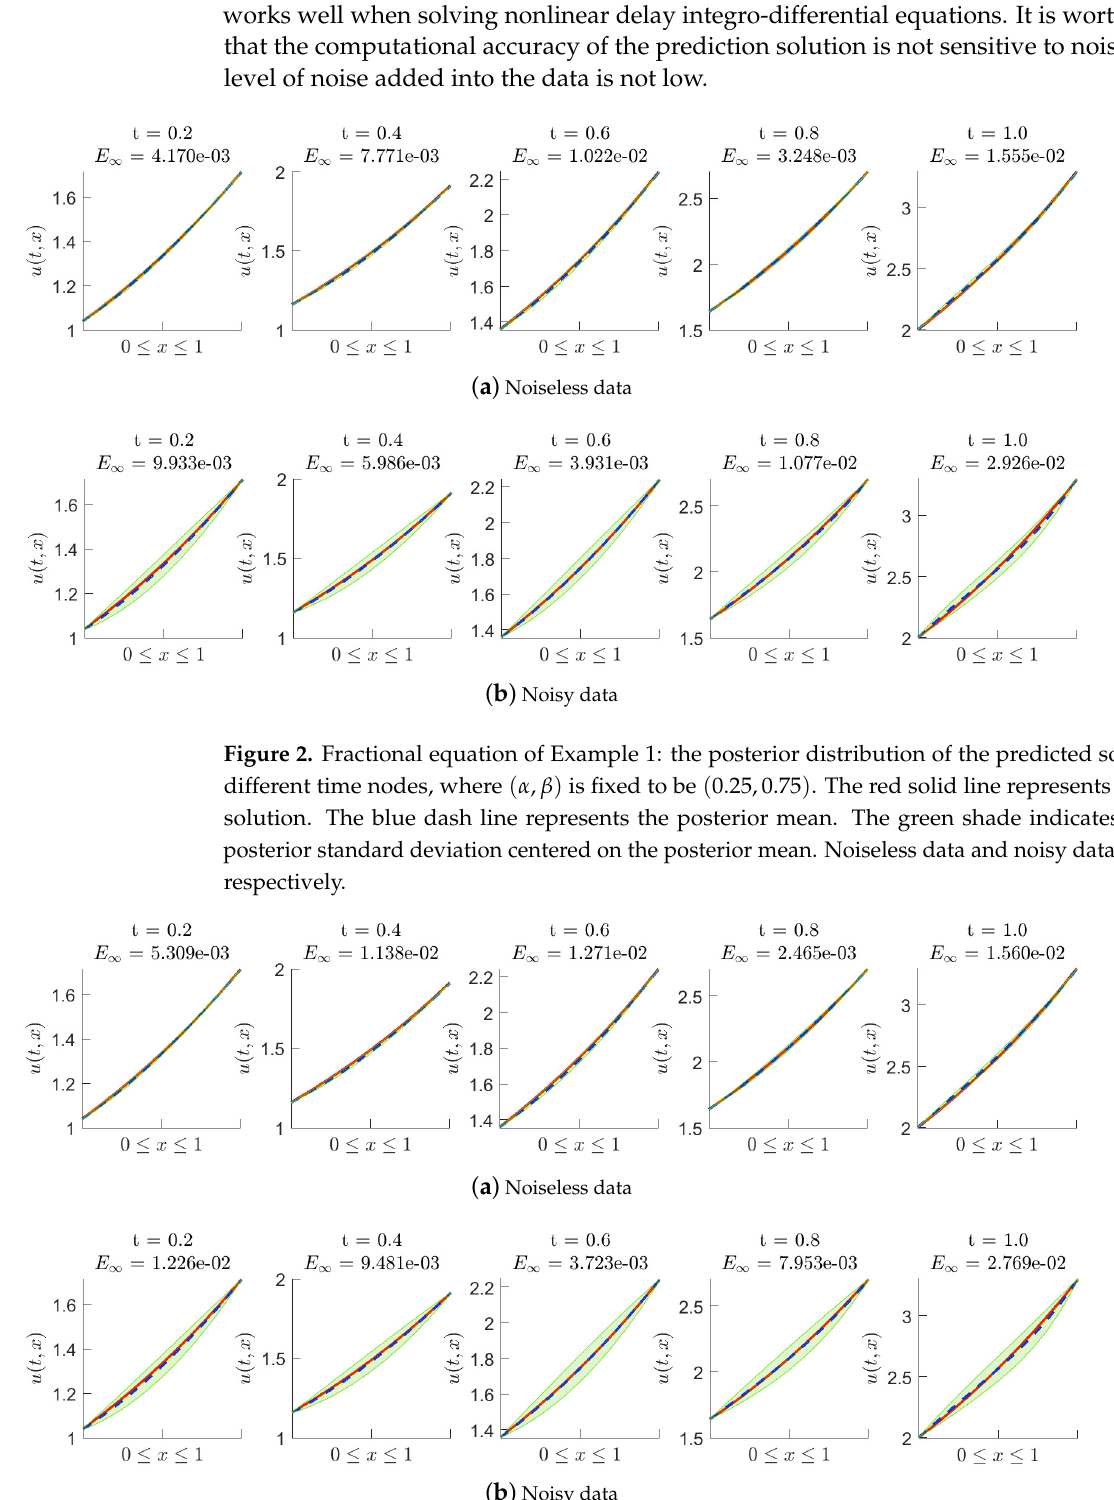
Figure 3. Fractional equation of Example 1: the posterior distribution of the predicted solution at different time nodes, where ( α , β ) is fixed to be ( 0.5,0.5 ) . Noiseless data and noisy data are used,